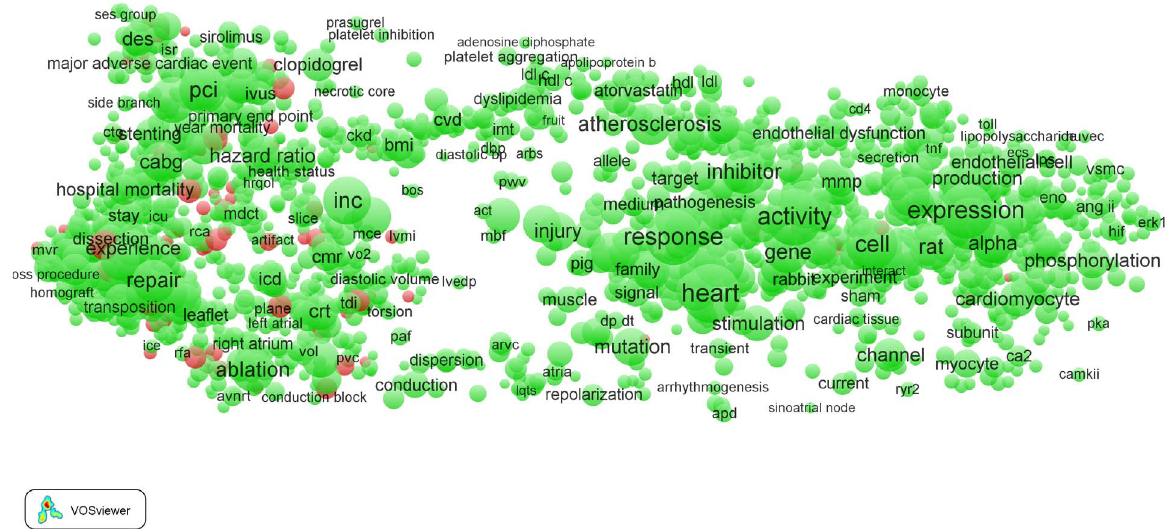
Figure 7. Term map of the Cardiac&cardiovascularsystems field.